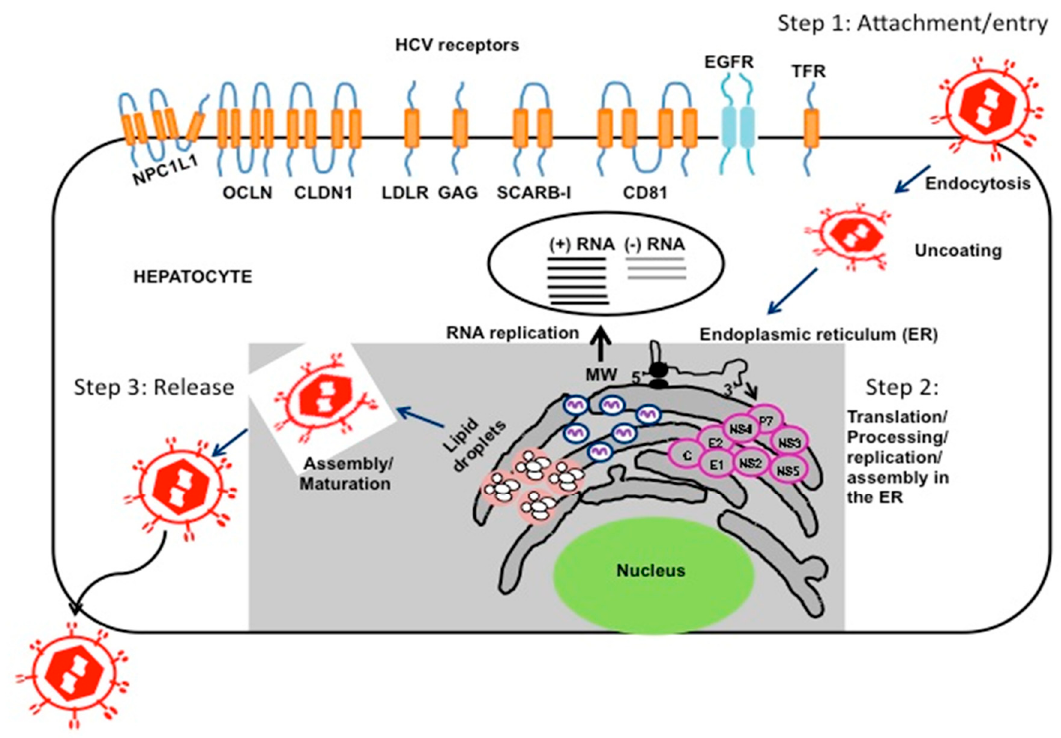
Figure 2. Infection cycle of HCV. The infection of HCV is initiated by the attachment and entry of virus particle through a number of cell surface receptors. The HCV RNA binds to ribosome and translates a single large polyprotein, which is a process into structural and non ‐ structural proteins. Accumulation of viral proteins induces endoplasmic reticulum (ER) ‐ stress response that leads to proliferation of ER ‐ membranes and formation of membranous web structure. HCV replication produces many new genomic positive strand and negative strand RNA. Genomic HCV positive strand RNA packages into complete infectious virus particles that release through secretory pathway.